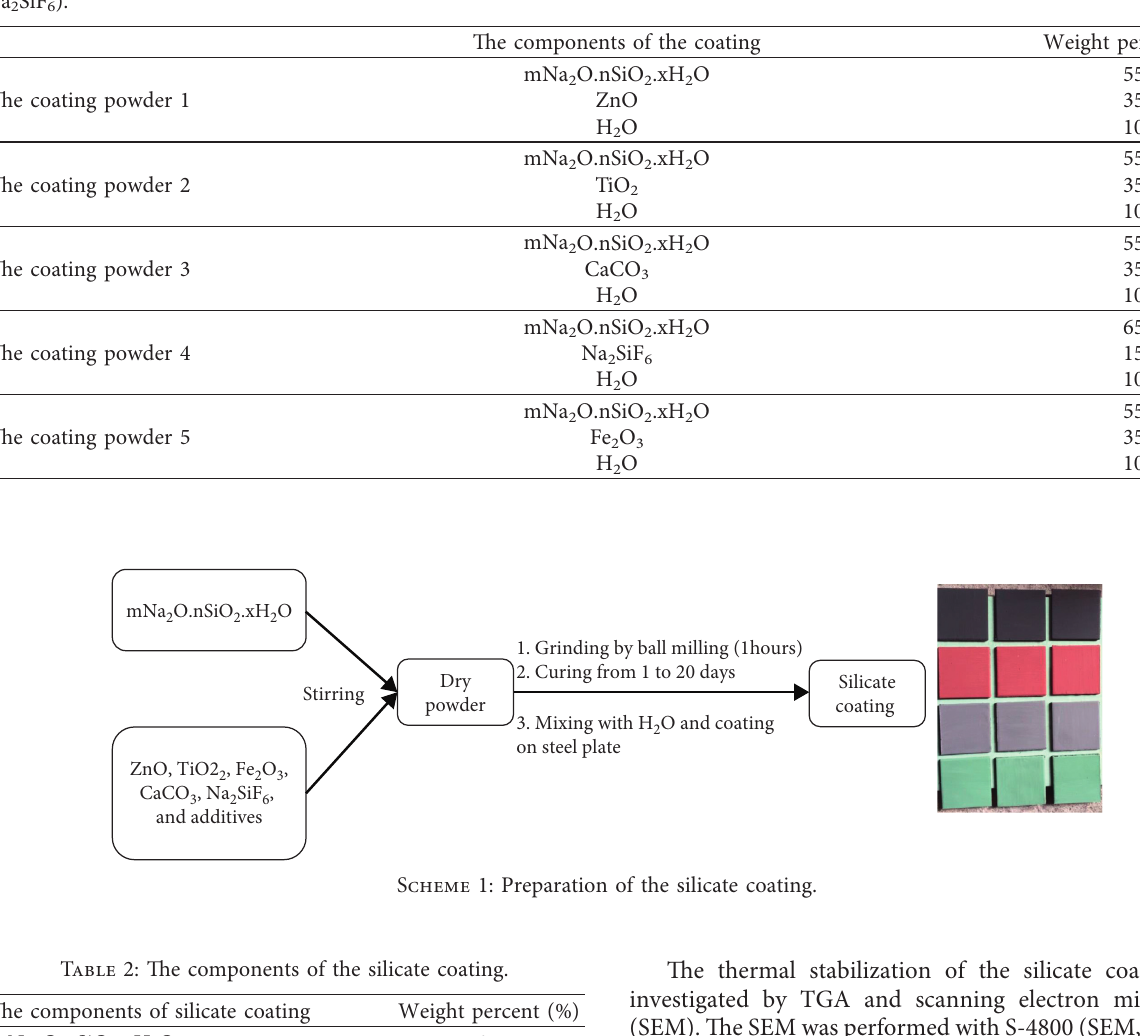
2 , Fe 2 O 3 , CaCO 3 , and